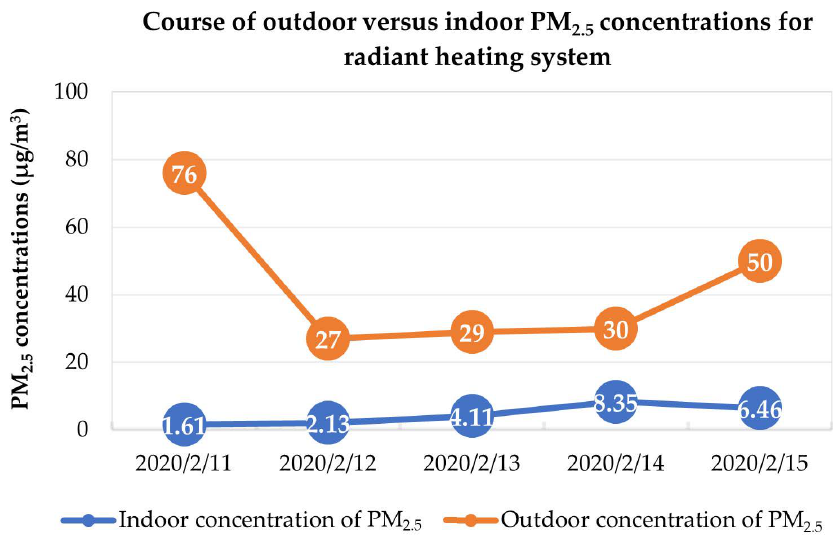
Figure 16. Courses of outdoor versus indoor PM 2.5 concentrations for RHS [33].